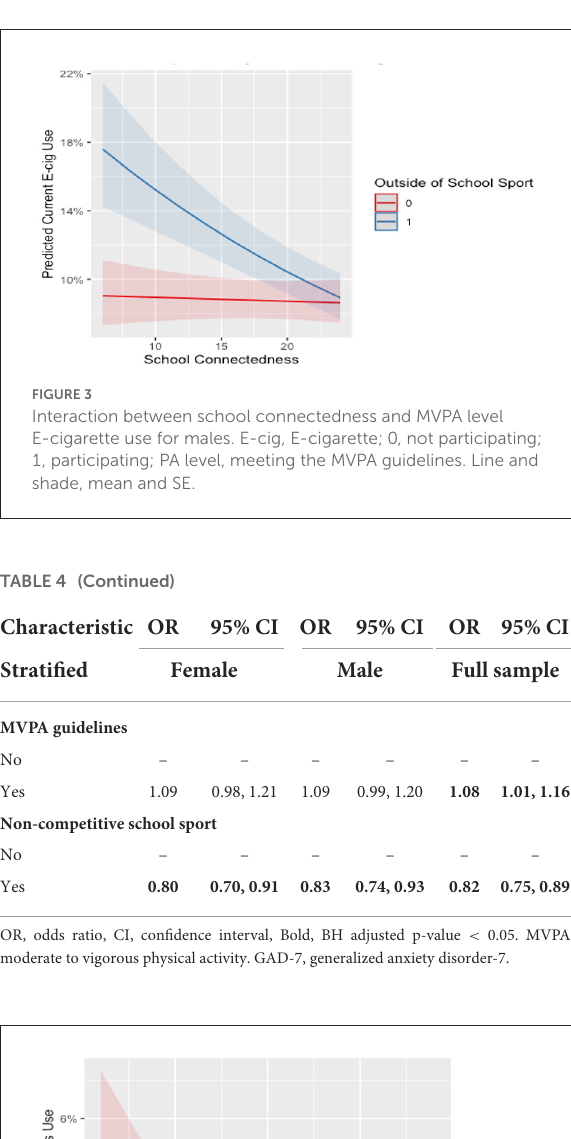
TABLE 4 Full model summaries for current cannabis use.